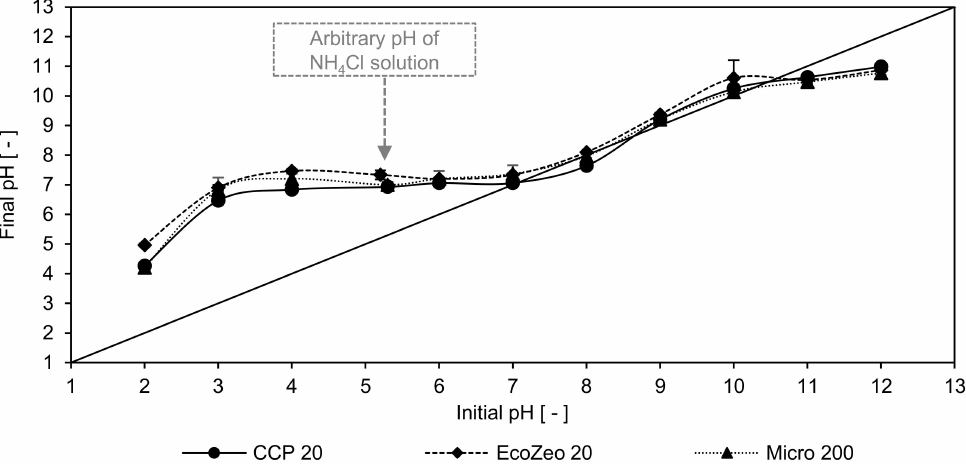
Figure 1. pH values of the filtrates after 20 h contact with CCP 20, Micro 200, and EcoZeo 20 (c 0 = 1000 mg NH 4 -N/L, sorbent ration 0.1 g CLI /mg NH4-N ) as a function of the initial pH values (adjusted pH values of the solution before contact with